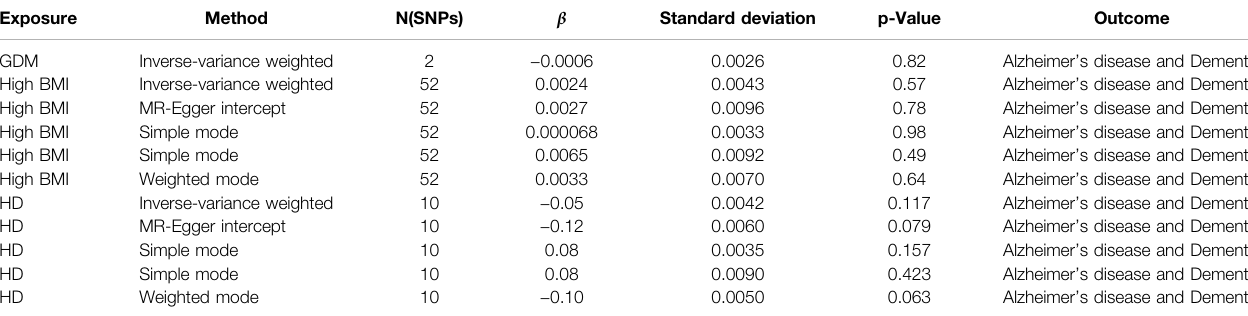
TABLE 1 | | Two-sample MR result: the causal effect of GDM, high BMI, HD on maternal AD/dementia.